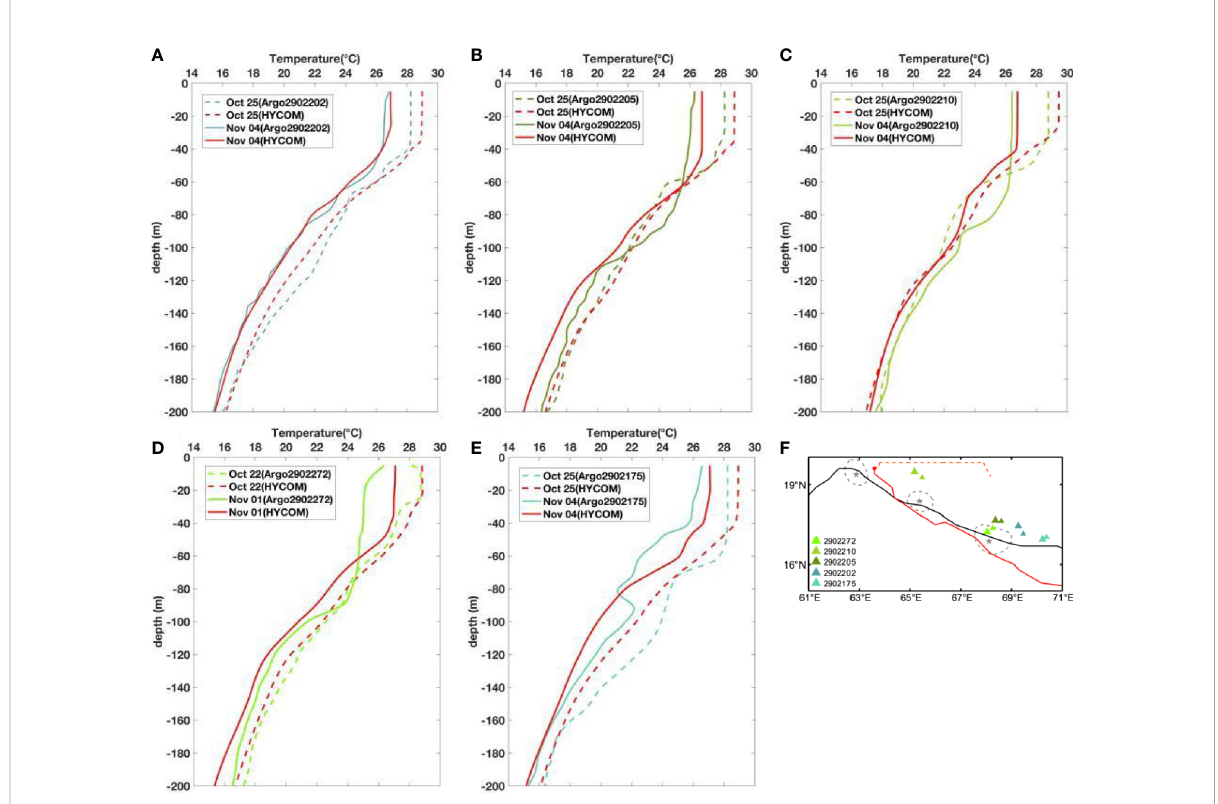
FIGURE 2 (A – E) show a comparison of temperature pro fi les obtained from Argo observations (different colours represent different Argo fl oats) and HYCOM model output results at different times. In (F) The Argo fl oats are represented by various coloured symbols. The small(large) symbols represent the location of Argo fl oats pre (post)-TC Kyarr/Maha. The grey dotted lines represent the shape and eddy centre of cyclonic eddies e1, e2, and e3 (November 07, 2019, eddy detection algorithms detected). The Argo fl oats are represented by various coloured symbols. The expression of TC tracks is the same as that in Figure 3. The red solid point represents the location of TC Maha on November